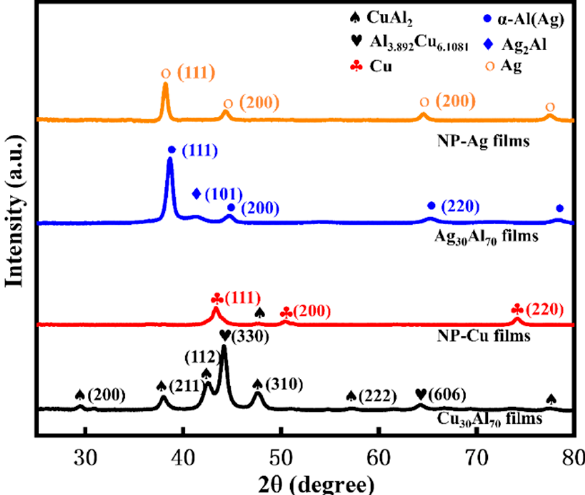
Figure 3. XRD results of the as-deposited Cu 30 Al 70 and Ag 30 Al 70 precursor films and as-dealloyed NP-Cu and NP-Ag films, respectively. The XRD patterns are identified by the database: Cu (PDF#00-004-0836), Al 3.892 Cu 6.1081 (PDF#00-019-0010), Al 2 Cu (PDF#00-002-1309), Ag 2 Al (PDF#00-014-0647) and Ag (PDF#00-004-0783).